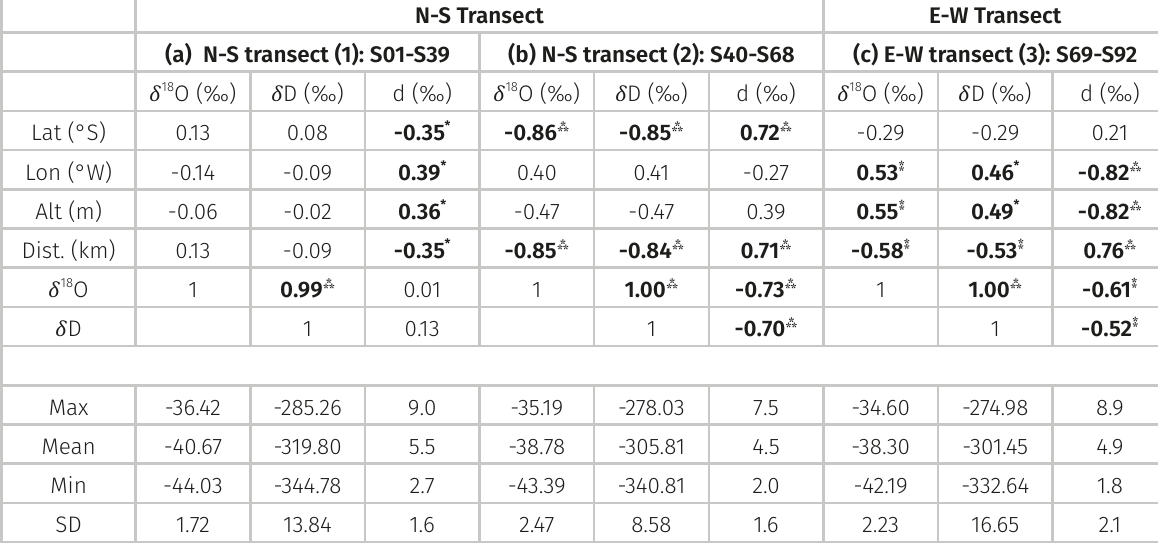
Table I. Top of the table: Linear correlation coefficients between isotopic content ( geographical parameters for each transect (a: N-S Transect (1) (south part); b: N-S Transect (2) (north part); c: E-W Transect (3)). Significant values (with a confidence level of 95.0%) are in bold. Bottom of the table: Maximum, minimum, mean (and standard deviation) values of the isotopic content for each